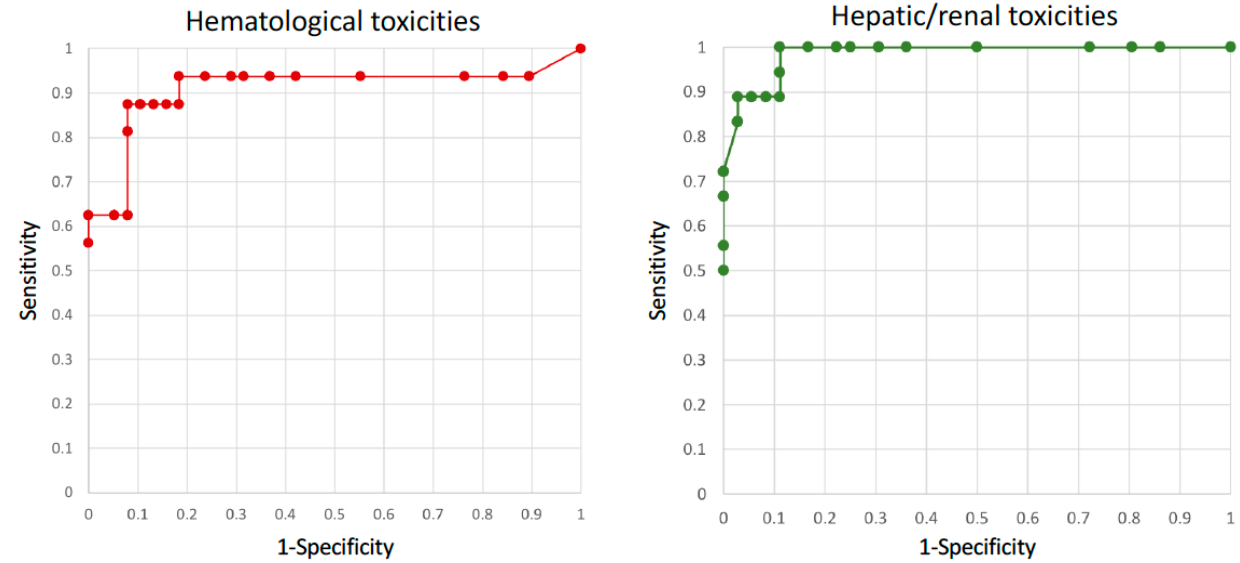
Figure 5. ROC analysis for hematological ( left ) and hepatic/renal toxicities ( right ), with area values of 0.910 and 0.985, respectively.